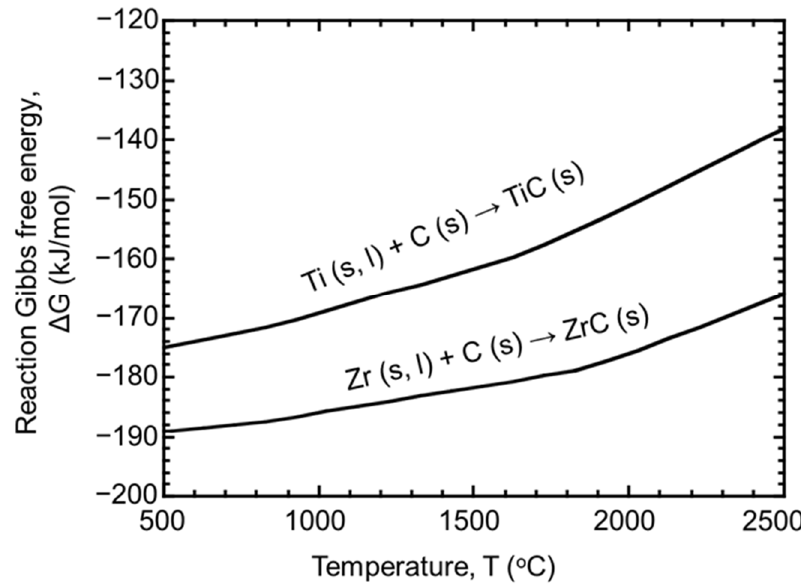
Figure 10. Gibbs free energy of formation for TiC and ZrC.